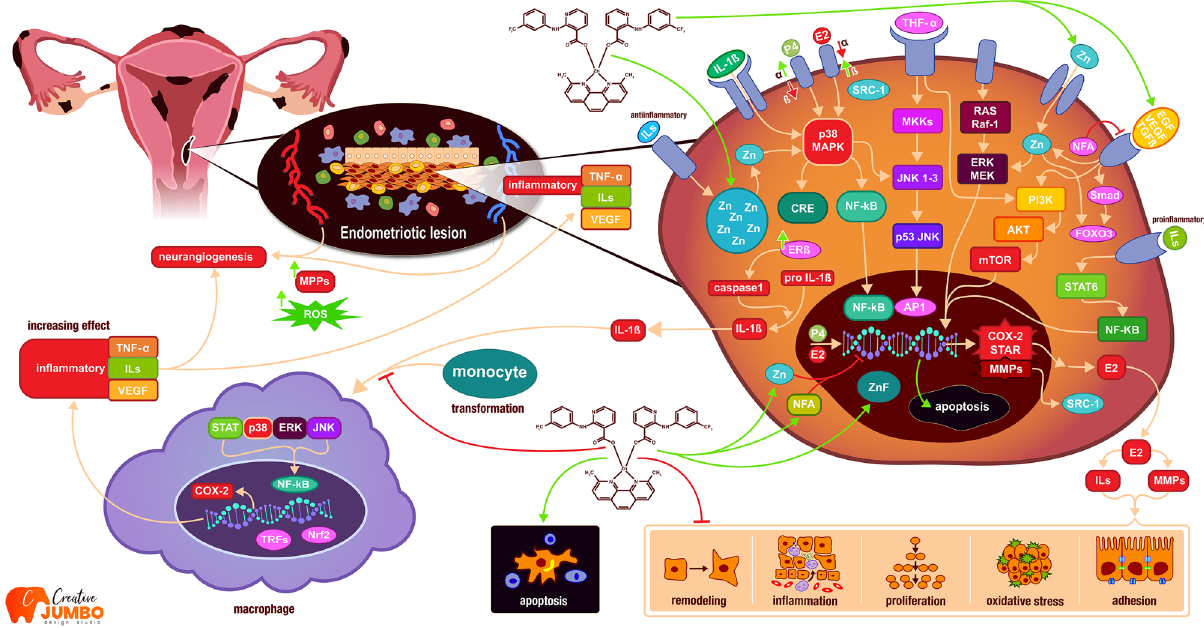
Figure 1. Mechanism of action of Zn-Nif complex on endometriotic